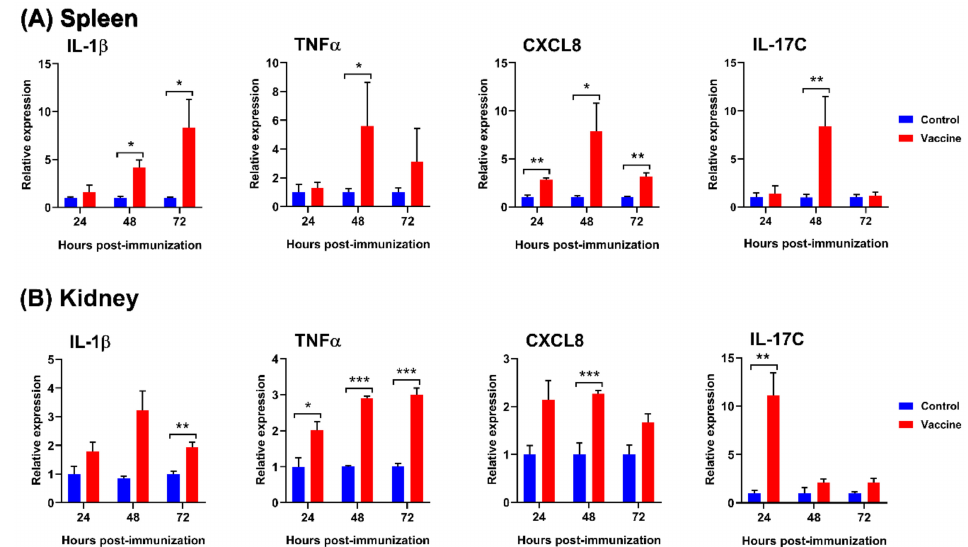
Figure 2. Comparative expression profiles of IL-1 β , TNF α , CXCL8, and IL-17C in the spleen ( A ) and kidney ( B ) from control and vaccinated fish (n = 6) at 24, 48, and 72 h after primary immunization. The expression of target genes was normalized to that of the RPL23 gene as a reference gene. The graph shows the relative expression levels in the vaccinated and control groups. Asterisks (*), (**), and (***) indicate significant di ff erences with p < 0.05, p < 0.01, and p < 0.001, respectively, from the control at each time